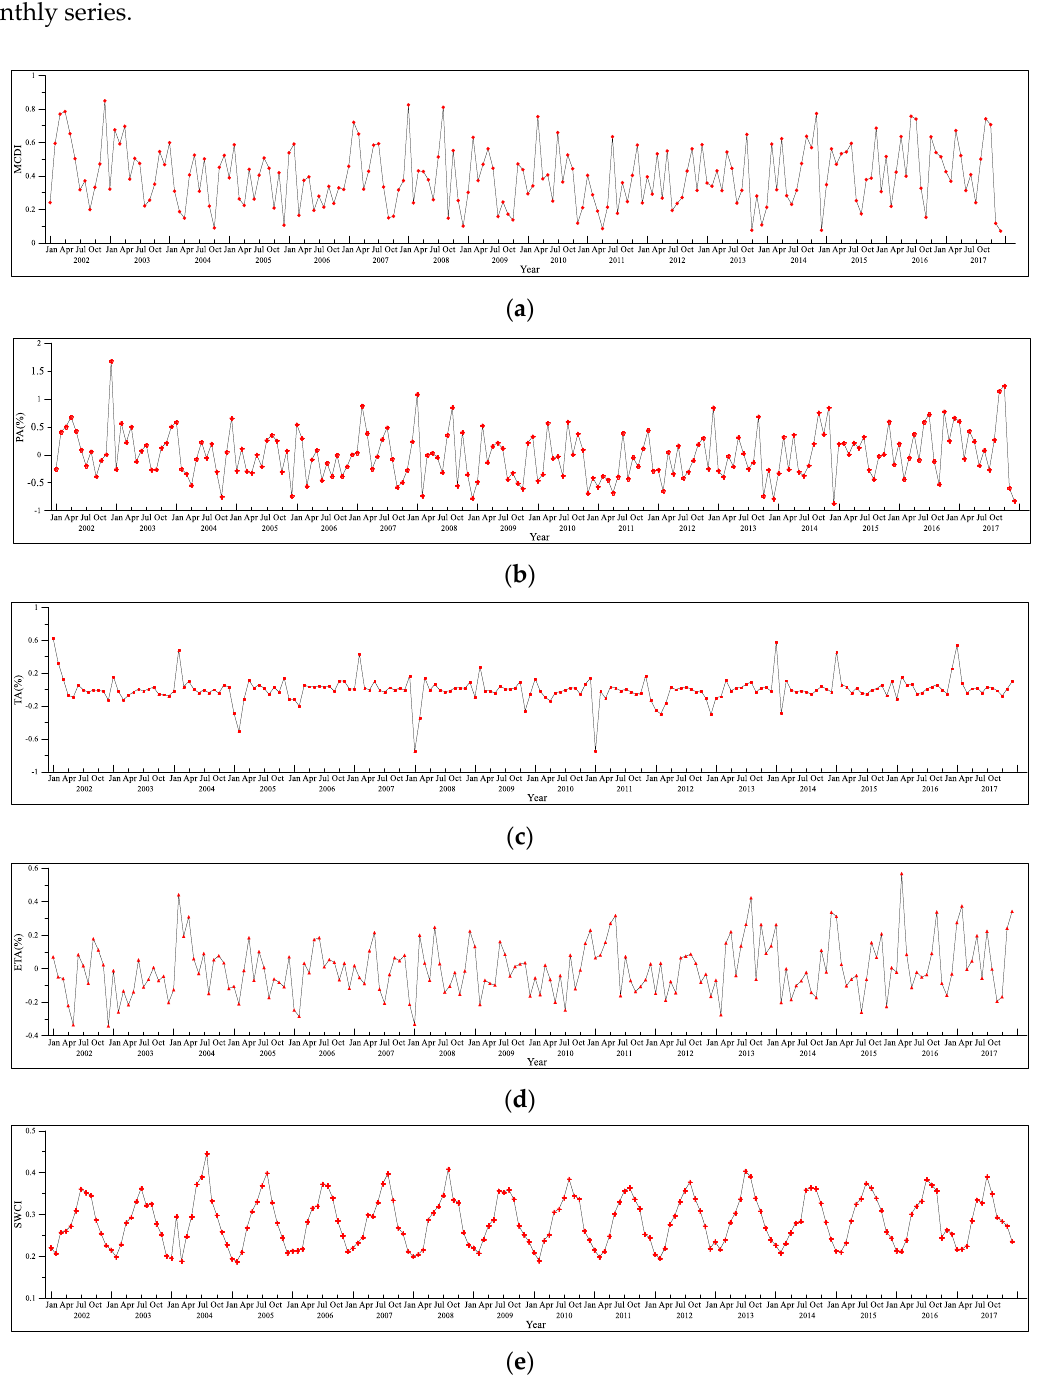
Figure 2. Monthly mean series of ( a ) MCDI, ( b ) PA, ( c ) TA, ( d ) ETA, and ( e ) SWCI for all stations in Hubei Province.